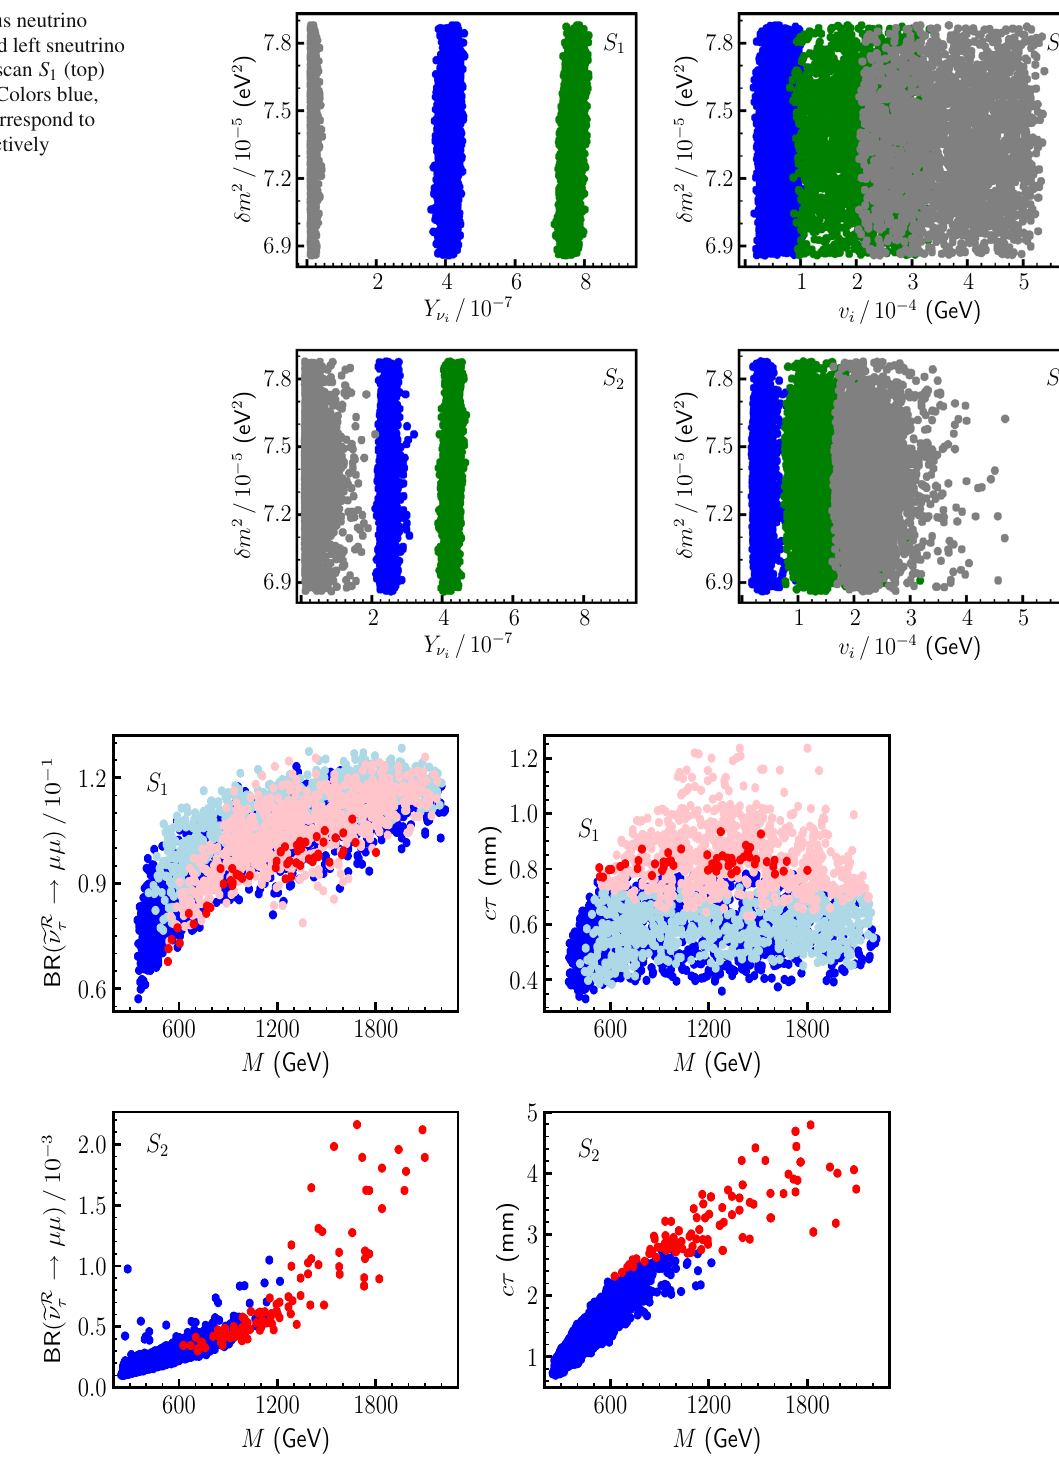
Fig. 5 (Left)Branchingratioversus M forthedecayofascalar (cid:2) ν τ LSP with m (cid:2) ν τ ∈ (61–100) GeV into μμ for scan S 1 (top) and S 2 (bottom). (Right) Proper decay length c τ of the scalar (cid:2) ν τ LSP versus M for scan S 1 (top) and S 2 (bottom). In all plots, the dark-red points indicate that the number of signal events is above 3 analyzing the prospects for the 13-TeV search with an integrated luminosity of 300fb − 1 , combining the μμ , e μ and ee channels, and considering also the optimization of